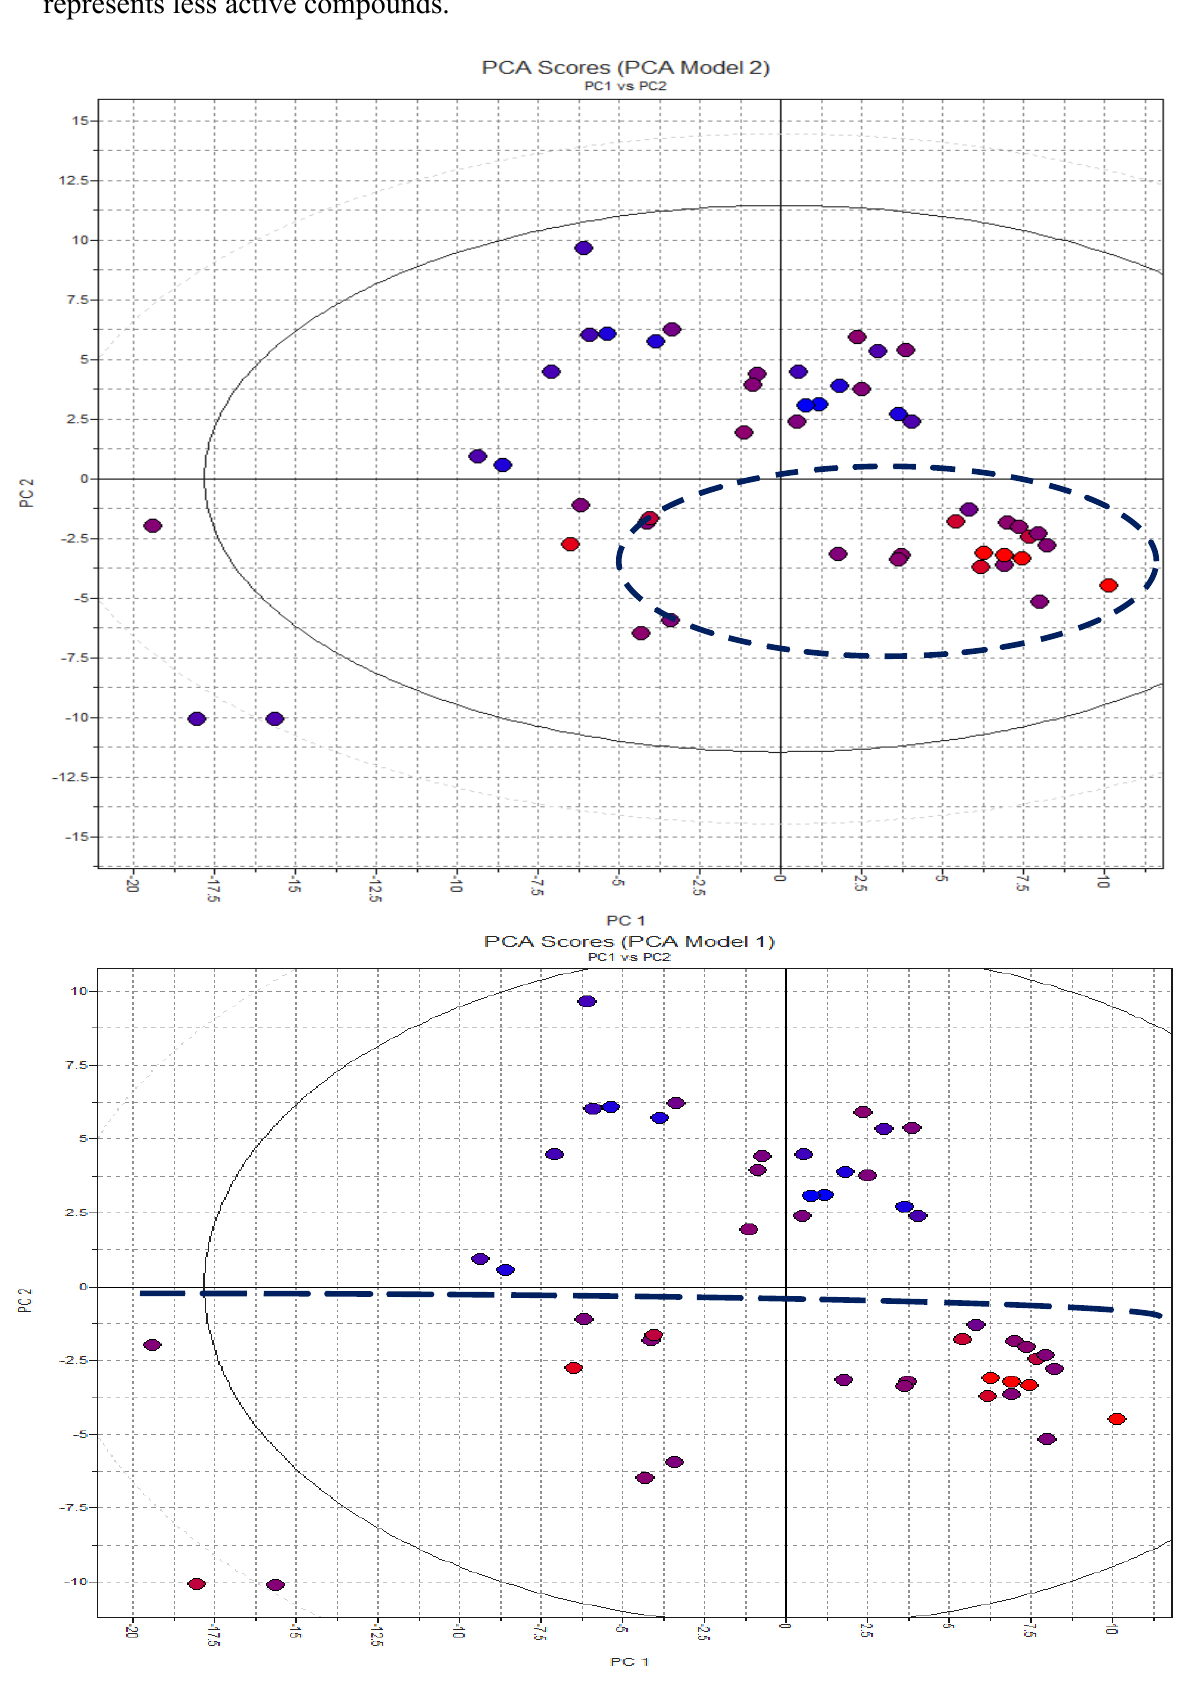
Figure 5. Positions of objects in relation to PC1 and PC2 components. Blue represents more active compounds, lilac represents compounds that are moderately active, and pink represents less active